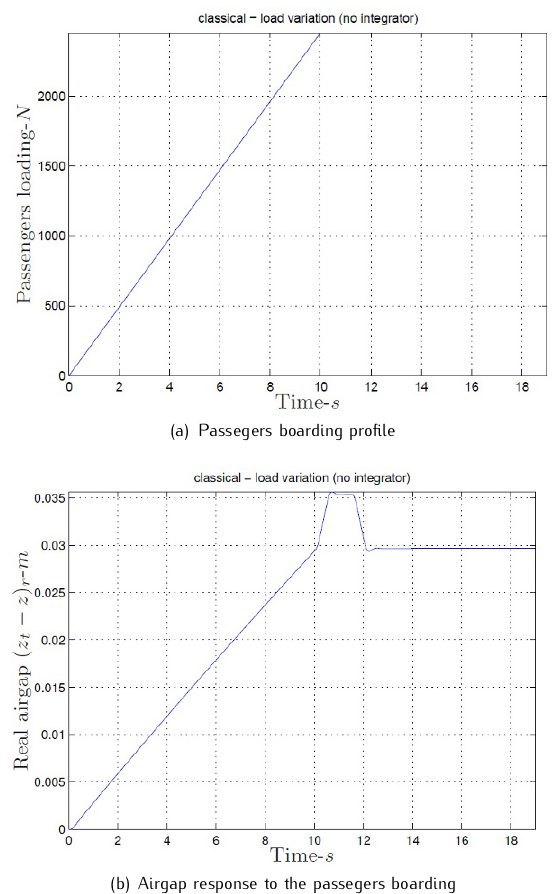
Figure 11. Passegers boarding profile and the airgap response.